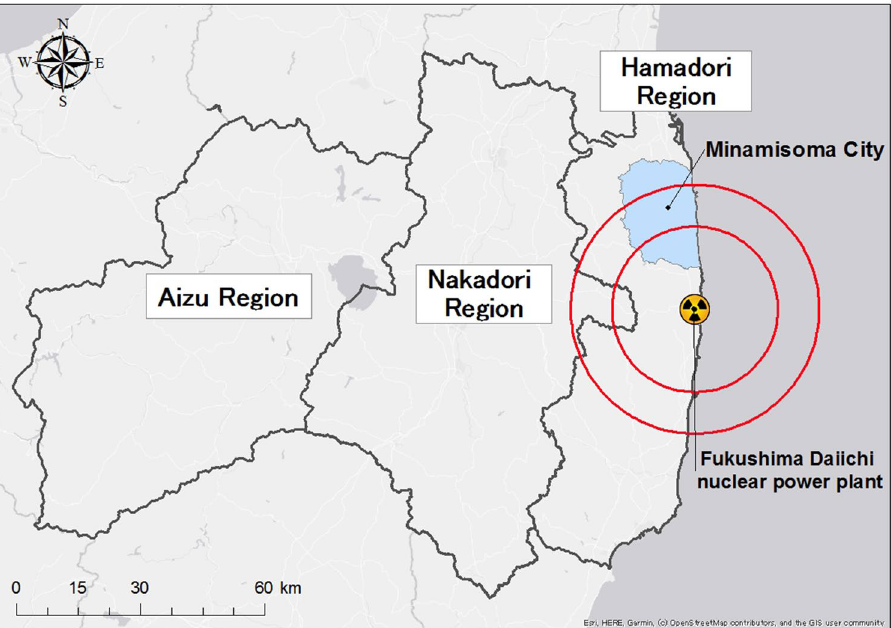
Figure 1. Location of Fukushima Daiichi nuclear power plant, Minamisoma City and regions of Fukushima Prefecture. Hamadori Region is a coastal area. Aizu Region is the most western inland region. Nakadori Region is located in the middle of these areas and is a city with prefectural government. Map data from ©